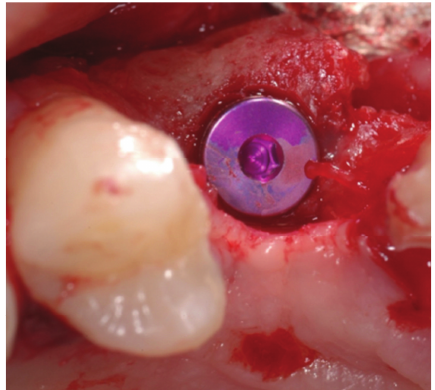
Figure 11: Dental implant inserted in a prosthetically guided po- sition in augmented bone.